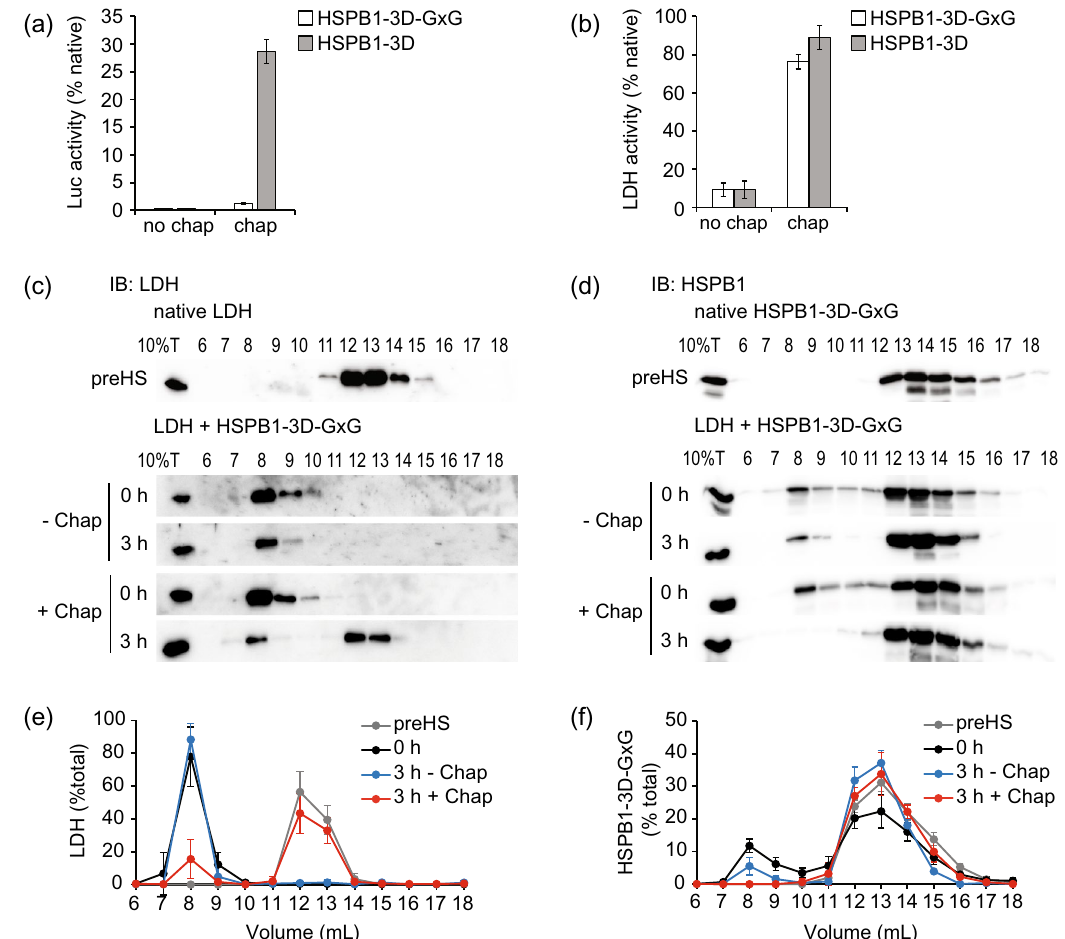
Figure 6. HSPB1-3D-GxG assists disaggregation of LDH but not luciferase. ( a , b ) Disaggregation of ( a ) luciferase and ( b ) LDH aggregates prepared with or without HSPB1-3D-GxG was assessed through the measurement of substrate enzymatic activity recovery as in Fig. 5. Aggregates prepared with HSPB1-3D were used as positive controls and reactions in the absence of chaperones were used as negative controls. Native substrate activity was set as 100% activity. ( c , d ) The effect of HSPB1-3D-GxG in LDH disaggregation. ( c ) LDH and ( d ) HSPB1-3D-GxG elution patterns at the beginning (0 h) and end (3 h) of reactions with (+ Chap) or without (− Chap) chaperones were determined by SEC and immunoblot (IB) as in Fig. 3. ( e , f ) Quantification of ( e ) LDH or ( f ) HSPB1-3D-GxG from C and D in eluted fractions are shown as percentage of the total amount of immunoblot signal. Error bars show standard deviations, n ≥